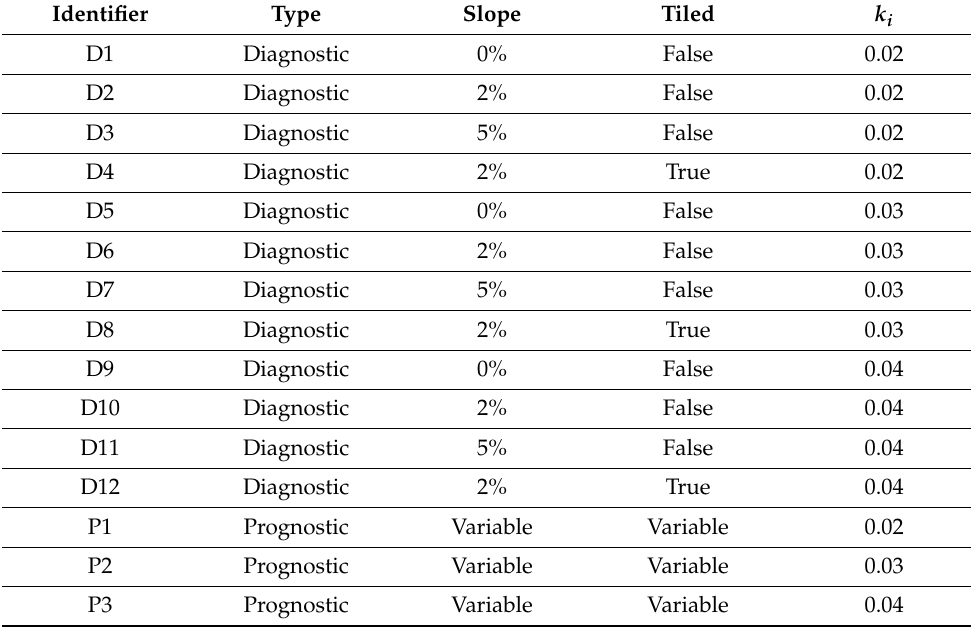
Table 1. HLM diagnostic and prognostic setups summary.